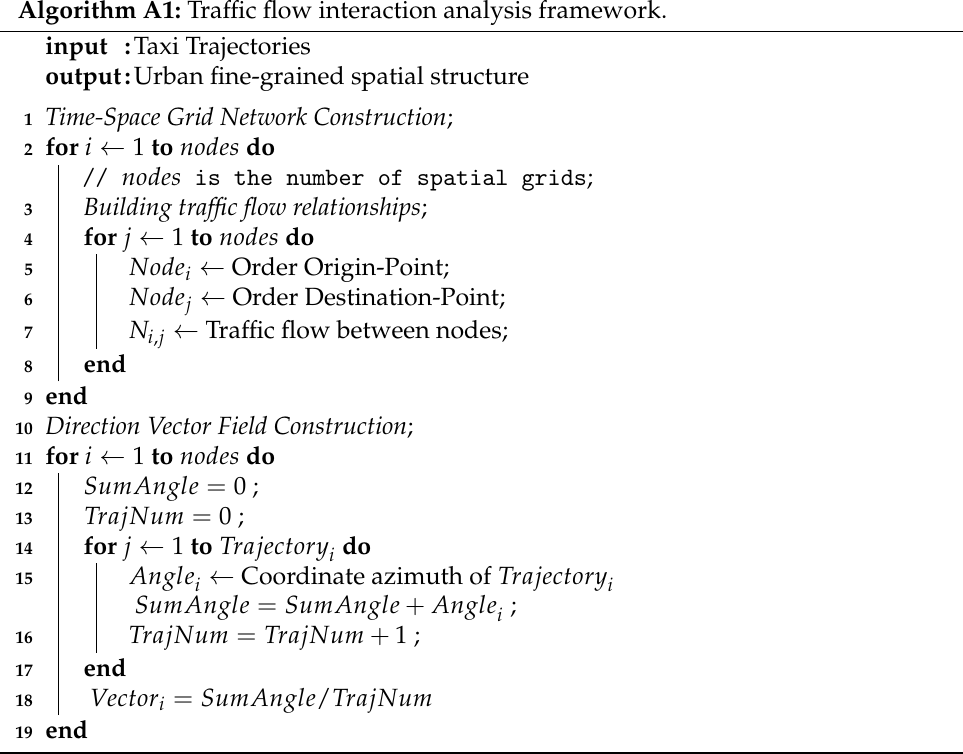
Algorithm A1: Traffic flow interaction analysis